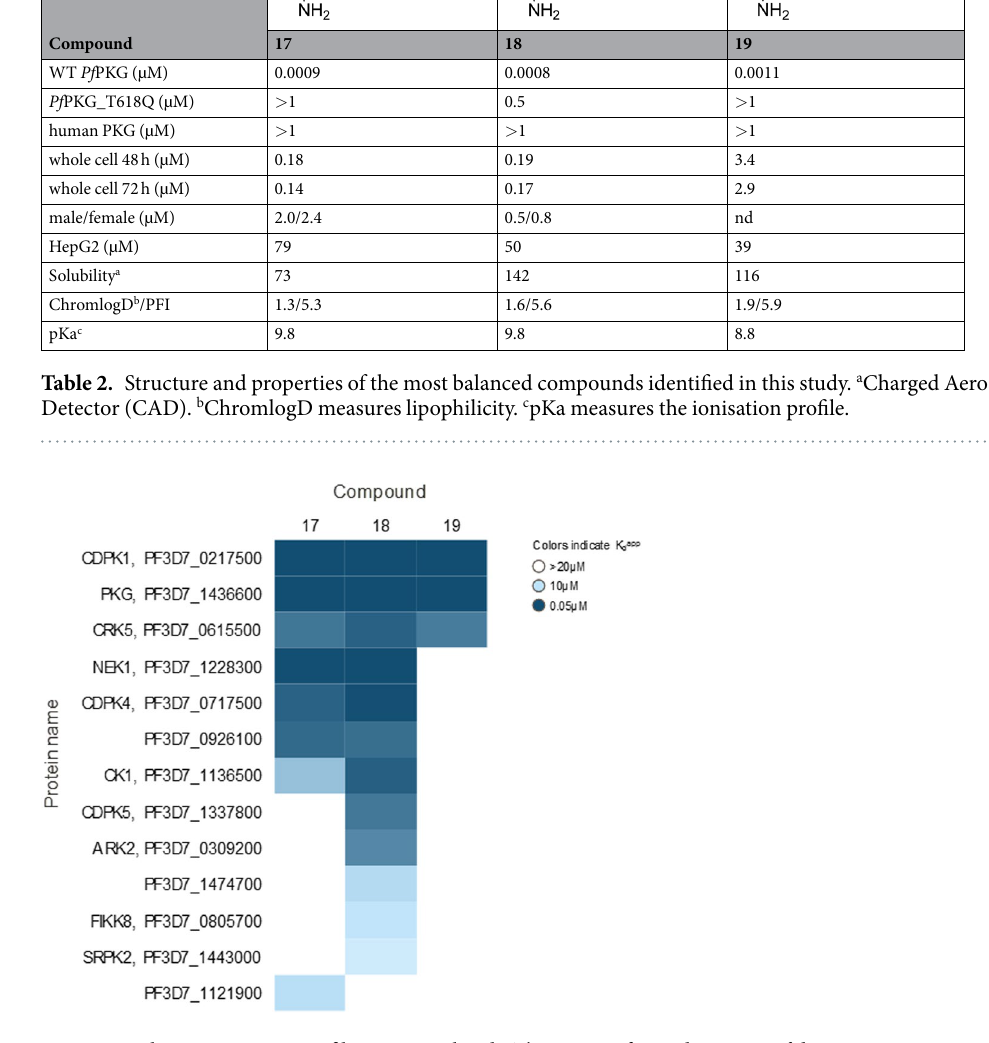
Figure 4. Chemoproteomic profiling on Kinobeads. This was performed using a P. falciparum protein extract to identify kinase targets for Compound 17, Compound 18 and Compound 19. The compounds were tested for their activity against 48 P. falciparum protein kinases and IC 50 values were generated. The heat map shows all P. falciparum protein kinases affected by any of the 3 compounds (maximum compound concentration analysed was 20 µ M, colours indicate apparent Kd